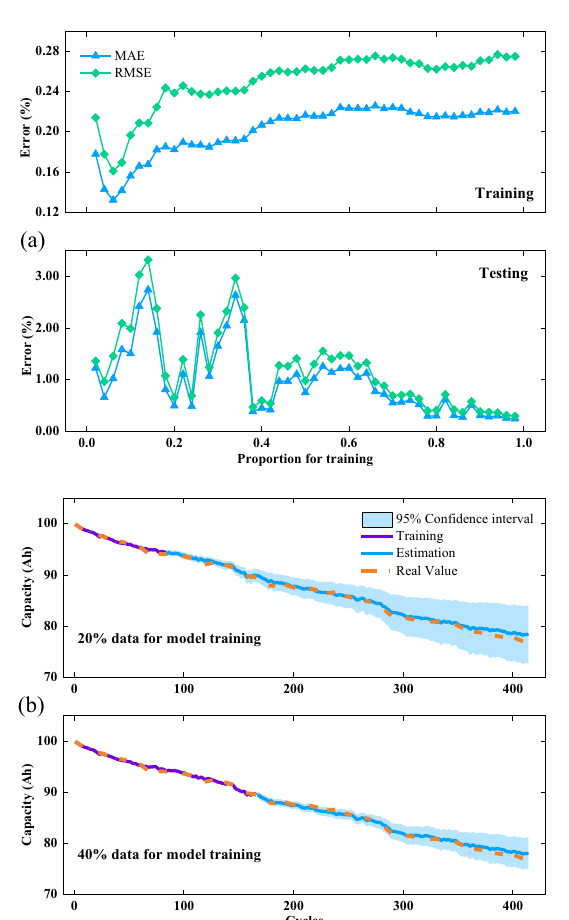
Figure 8 Capacity estimation results for the battery pack: a the errors with different proportion of data for model training, b estimation